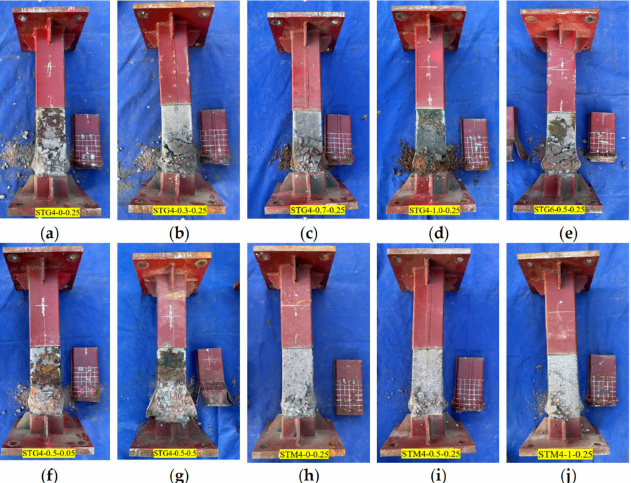
Figure 6. ( a ) Failure of the inner GRBAC for STG4-0-0.25; ( b ) failure of the inner GRBAC for STG4-0.3- 0.25; ( c ) failure of the inner GRBAC for STG4-0.7-0.25; ( d ) failure of the inner GRBAC for STG4-1-0.25; ( e ) failure of the inner GRBAC for STG6-0.5-0.25; ( f ) failure of the inner GRBAC for STG4-0.5-0.05; ( g ) failure of the inner GRBAC for STG4-0.5-0.5; ( h ) failure of the inner GRBAC for STM4-0-0.25; ( i ) failure of the inner GRBAC for STM4-0.5-0.25; ( j ) failure of the inner GRBAC for